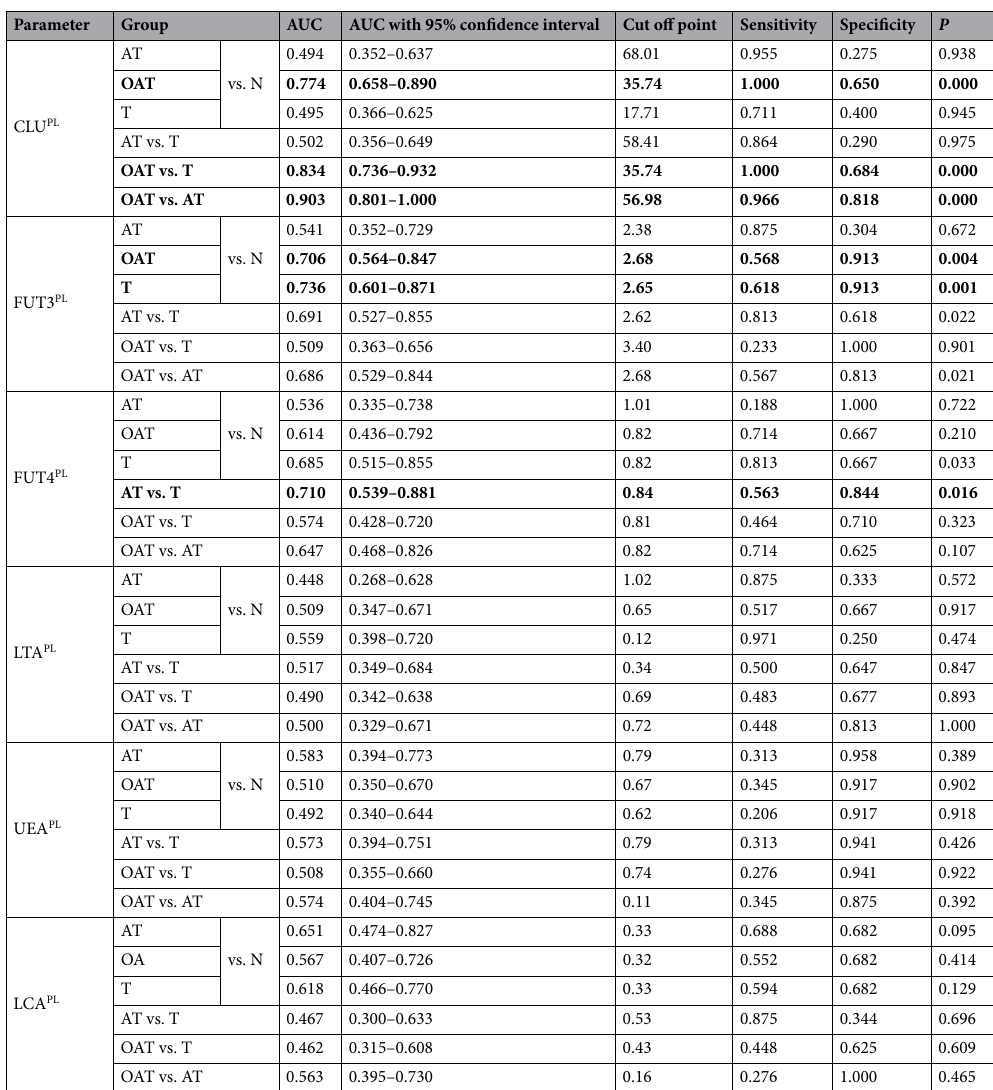
Table 3. Summary of receiver operating characteristic (ROC) curves for seminal plasma parameters. CLU PL — seminal plasma CLU concentration; FUT3 PL —seminal plasma FUT3 concentration; FUT4 PL —seminal plasma FUT4 concentration; LTA PL —relative reactivity of seminal plasma CLU glycans with Lotus tetragonolobus agglutinin; UEA PL —relative reactivity of seminal plasma CLU glycans with Ulex europaeus agglutinin; LCA PL —relative reactivity of seminal plasma CLU glycans with Lens culinaris agglutinin. Area under the ROC curve (AUC) is given with 95% confidence interval. Data with AUC equal or greater than 0.706 are marked in bold. Based on the AUC, the clinical value of laboratory test can be defined as: 0–0.5—zero, 0.5–0.7—limited, 0.7–0.9—moderate and >